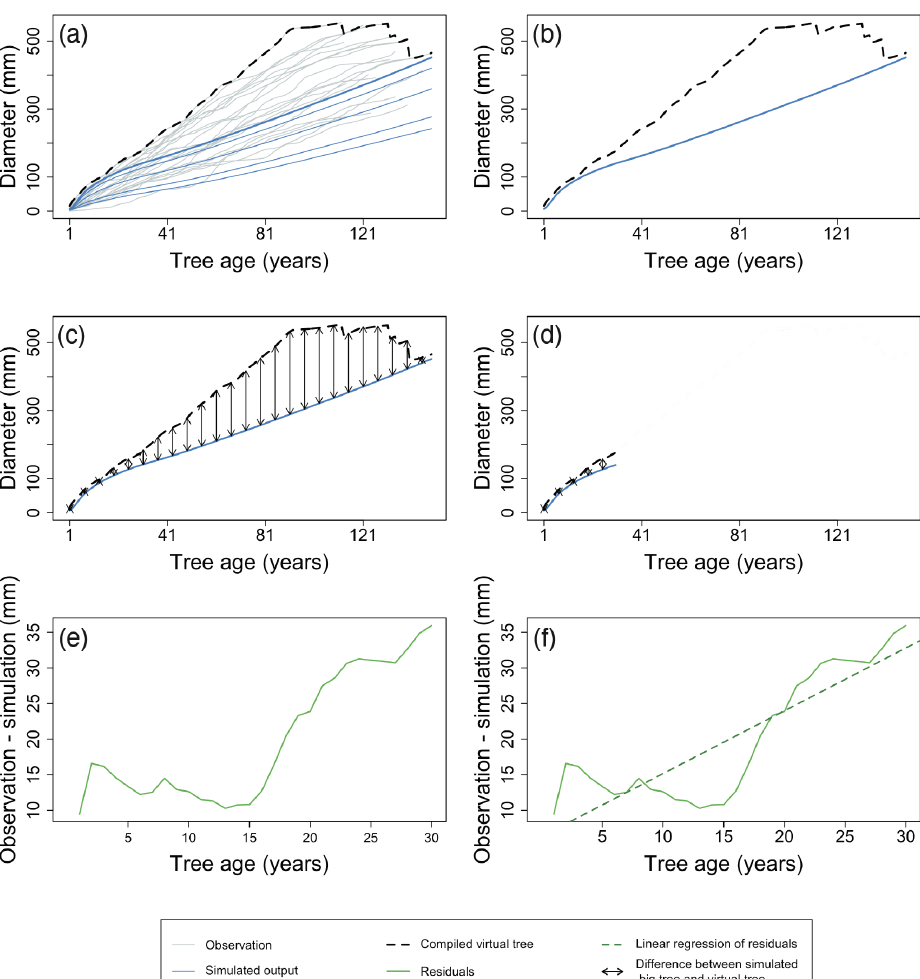
Figure 7. Example of the major steps in calculating the metrics of the benchmark for diameter increment in young trees. After aligning the TRW records of the individual trees by their age, a virtual tree is constructed by taking the maximum observed diameter of all trees for each year (a) . Observations are shown as grey lines, and the simulation is shown as blue lines. The largest diameter class from the simulation is presented by the bold line. Black dotted lines represent the yearly maximum of the observations. The growth of the virtual tree is then compared to the simulated growth of the largest diameter class (b) by calculating the RMSE (c) and trend of the residuals (e, f) . The x axes of panels (e) and (f) zoom in on the selected period, the green line denotes the model residuals, and the green dotted line is the linear regression of the model residuals. These calculations are limited to the first decades of the time series (d) to compensate for the bias caused by the fact that the old fast-growing trees died well before sampling took place. By using different approaches to evaluate the growth of young (this benchmark) and mature trees (the previous benchmark), the comparison accounts for the observation that the drivers of ring growth change when the trees grow taller (Cook, 1985). Observations and simulation are from Pinus sylvestris site in Scotland, archived as brit021 (Schweingruber, 1995). The calculated RMSE (d) was 21.86mm, and the slope of residuals (f) was 0.88mmyr − 1 for this